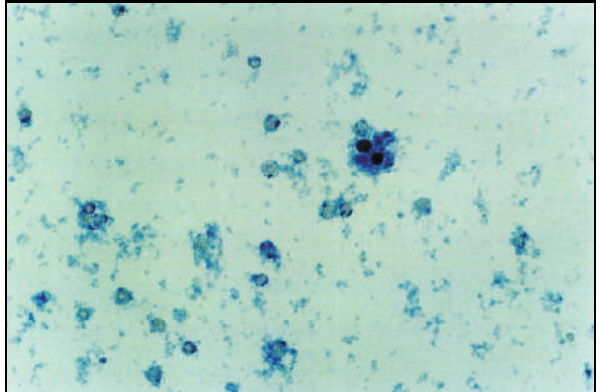
FIGURA 2b – Aspecto das células tumorais a microscopia óptica entre 5 e 10 minutos de incubação com 0,50 ml S.T., pelo teste de